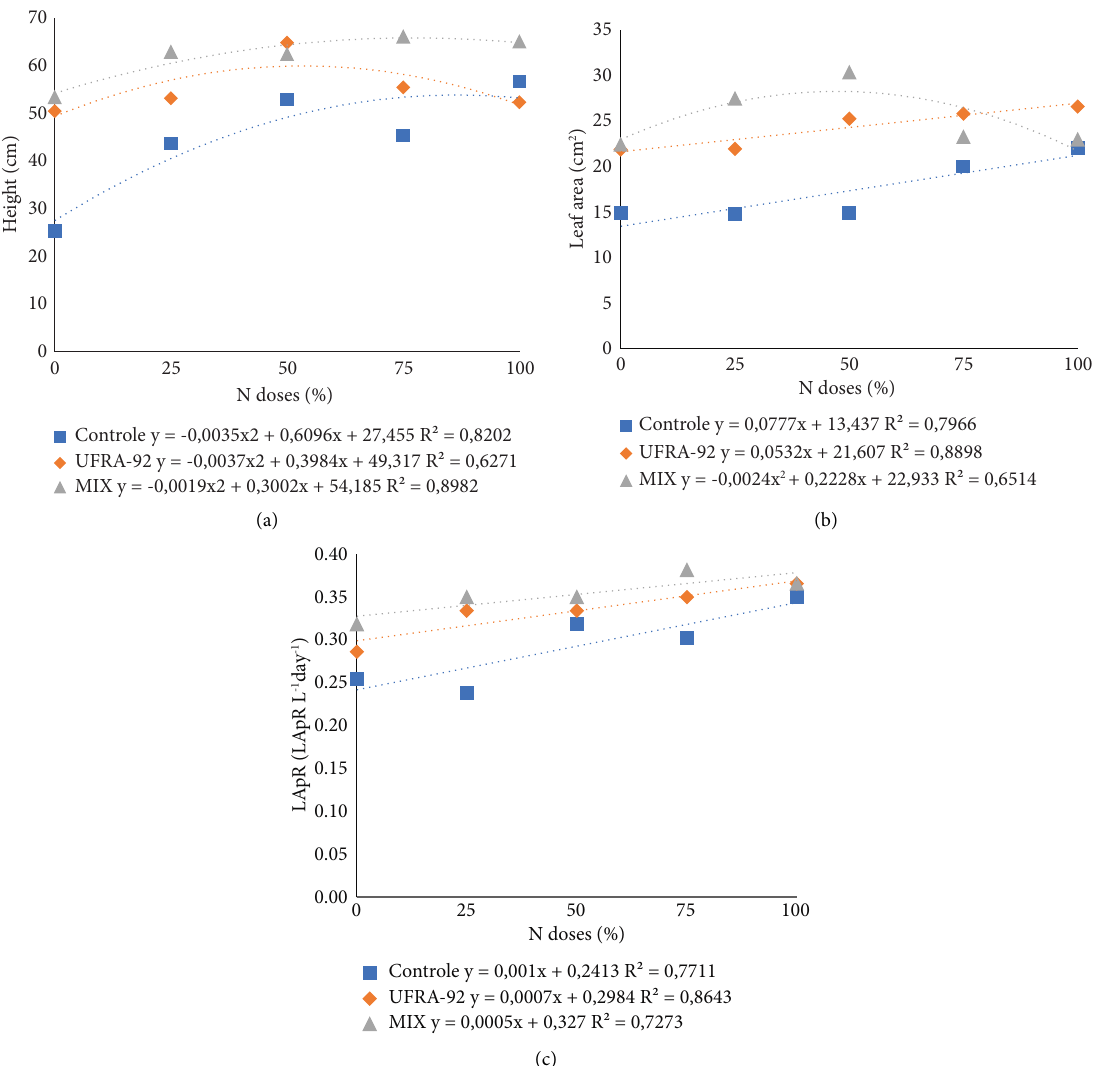
Figure 1: Efect of inoculation with Bacillus subtilis (UFRA-92) and Trichoderma asperellum +UFRA-92 (MIX) as a function of nitrogen doses on height (a), leaf appearance rate (b), and leaf area (c) of Urochloa brizantha cv. Marandu.